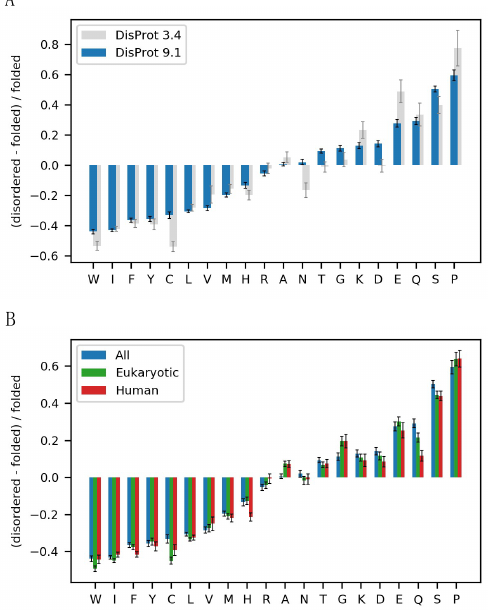
Figure 2. The disorder alphabet revisited. ( A ) Sequence enrichment profile of IDPs with the enrichment of amino acids in disordered proteins from the newest (9.1) and the older version (3.4) of DisProt [13–15] compared to folded proteins, defined, respectively, as non-redundant sequences in the PDB or the standard Composition Profiler dataset PDBselect25. ( B ) Sequence enrichment profiles for eukaryotic and human IDPs from DisProt v. 9.1 using a background set of non-redundant sequences in the PDB. Error bars show the boot strap confidence intervals with a statistical significance value of 0.05.